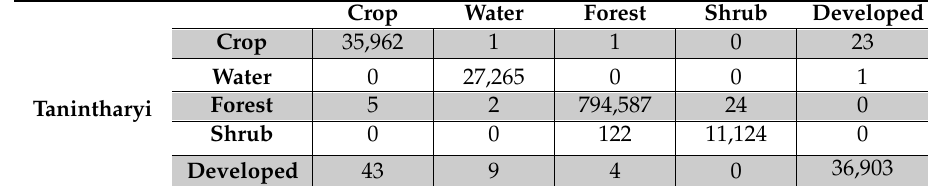
Table 3. Example Tanintharyi error matrix for a broad class map using fused Landsat-8, PALSAR-2, and Sentinel-1 imagery where the withheld kappa statistic was 0.92.